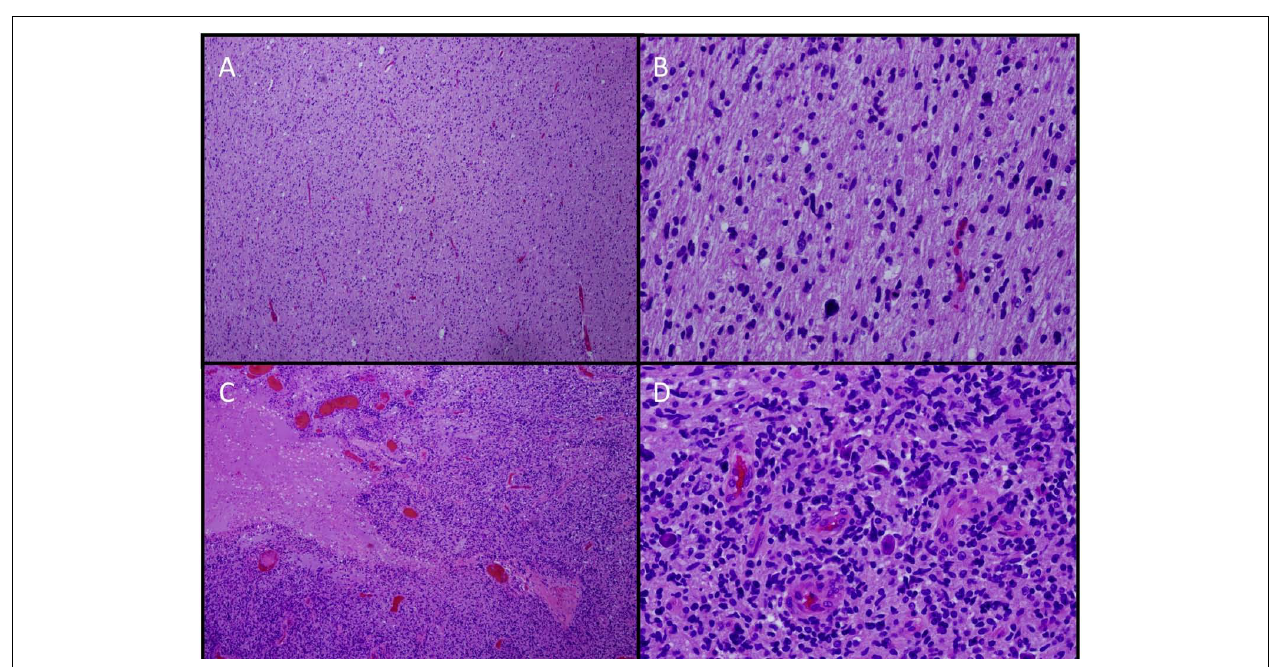
FIGURE 3 | Histologic geographic variability of DIPG. × 4 (A,C) and × 20 (B,D) . Hematoxylin and eosin stains from different sections of a single tumor showing low-grade (A,B) and high-grade (C,D) areas.